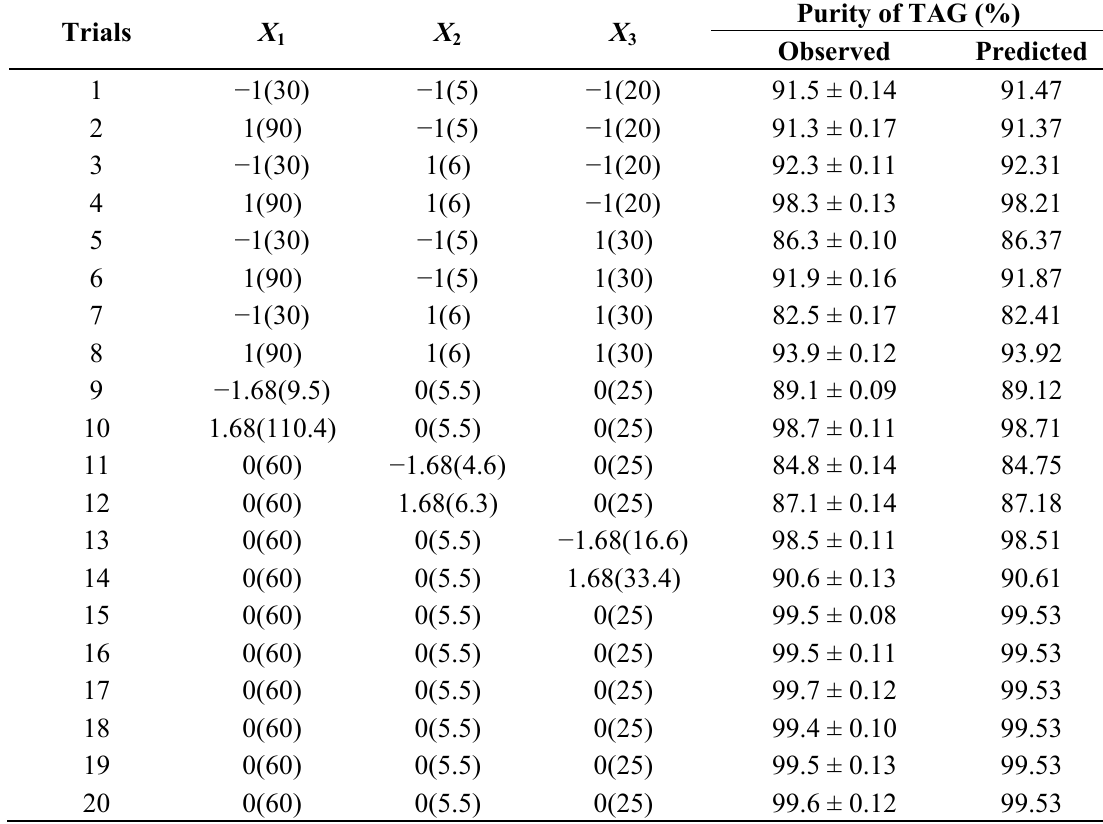
Table 1. Experimental design and results of CCRD optimization experiment a